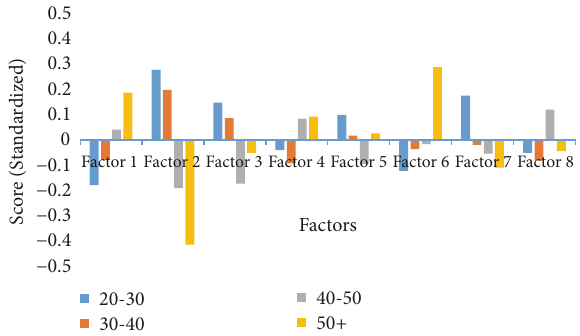
Figure 5: DSQ factor scores broken down by age groups.